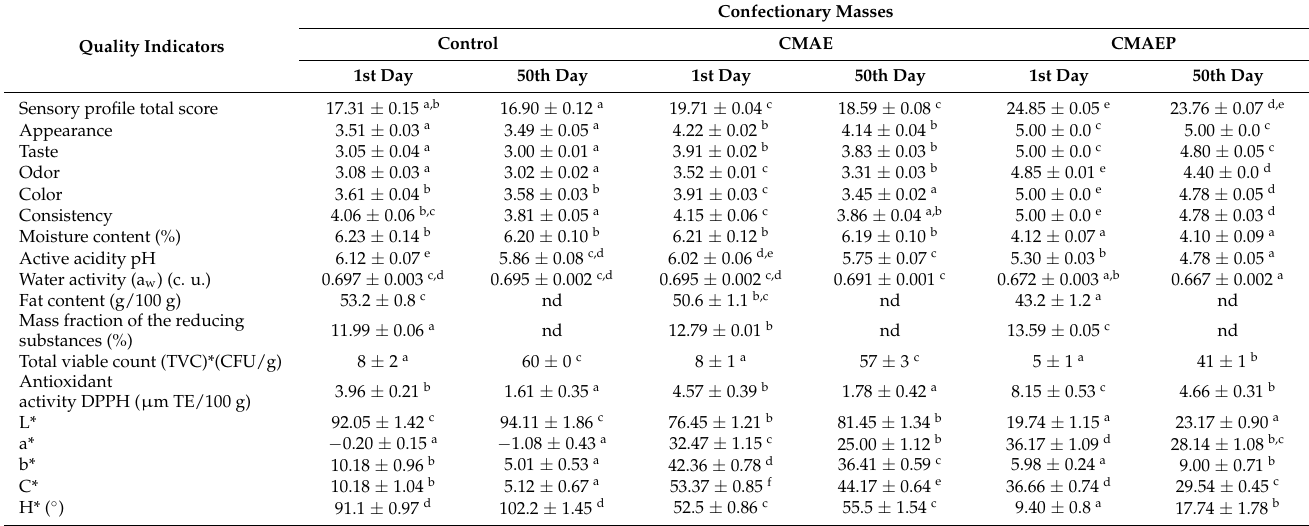
Table 4. Sensory profile, physicochemical and microbiological quality indicators, antioxidant activity and color characteristics of confectionary masses with added extract and aronia powder compared to the control (the results are presented as means ± standard